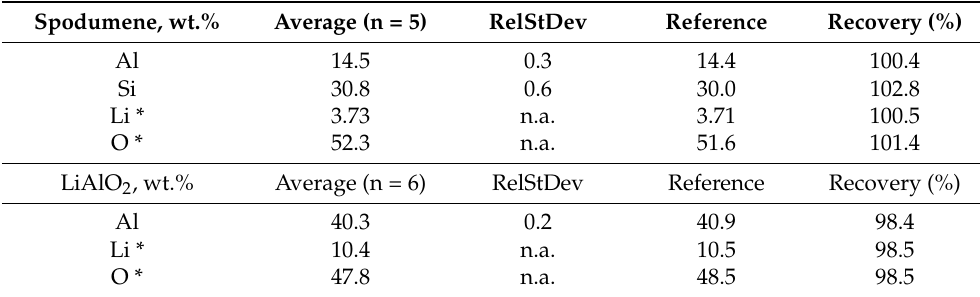
Table 2. Measured and calculated values for spodumene (international reference: Astimex) and pure LiAlO 2 (in-house reference). * calculated values.